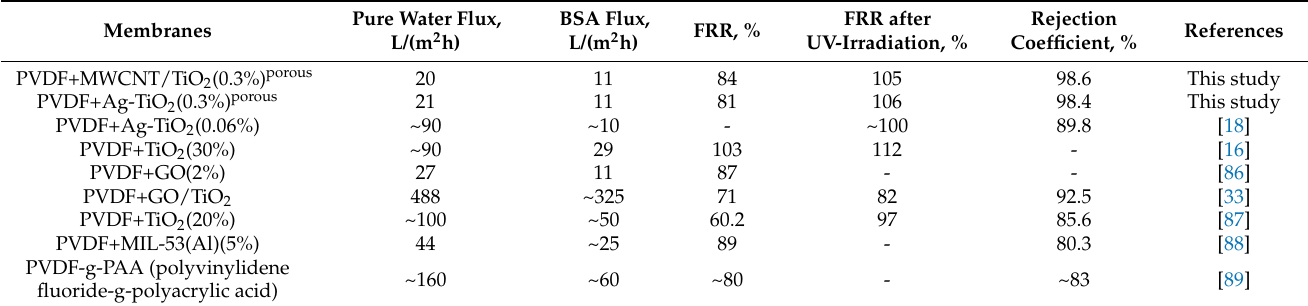
Table 5. Ultrafiltration performance of the porous PVDF+MWCNT/TiO 2 (0.3%) porous and PVDF+Ag- TiO 2 (0.3%) porous membranes and the PVDF-based membranes described in the literature.